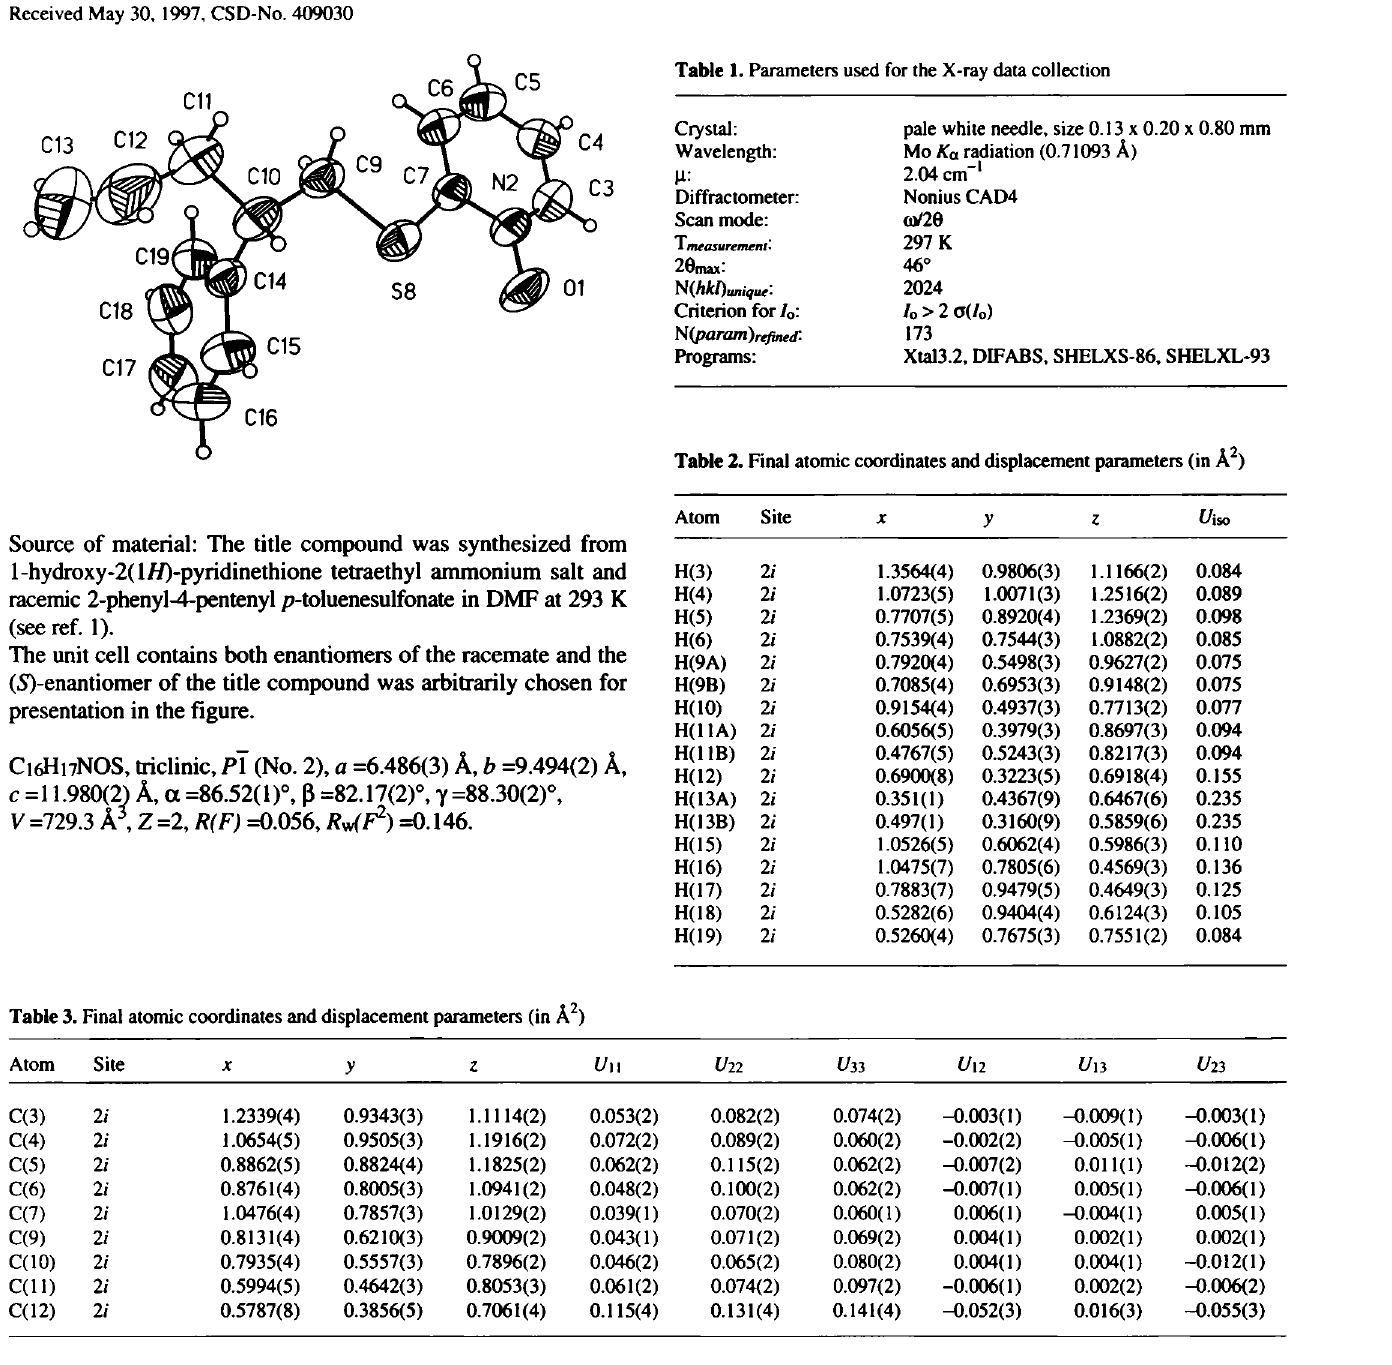
Table 1. Parameters used for the X-ray data collection Crystal: